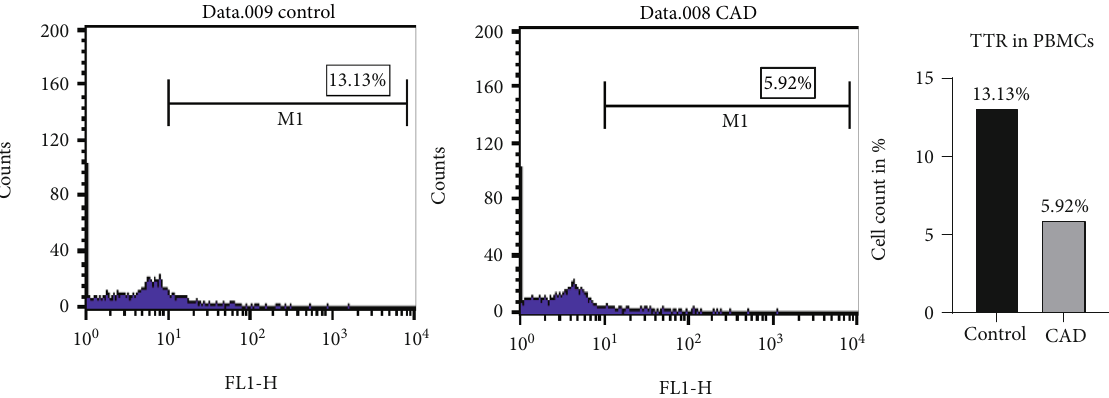
Figure 4: FACS histogram of the TTR protein expression in the whole blood cell population: observed percentage of the TTR protein expression in CAD (5.92%) compared to healthy control (13.13%) indicates the 2-fold downexpression in CAD patients by calculating the number of cells out of the parent population (total cells) that showed positive staining after gating the unstained cell